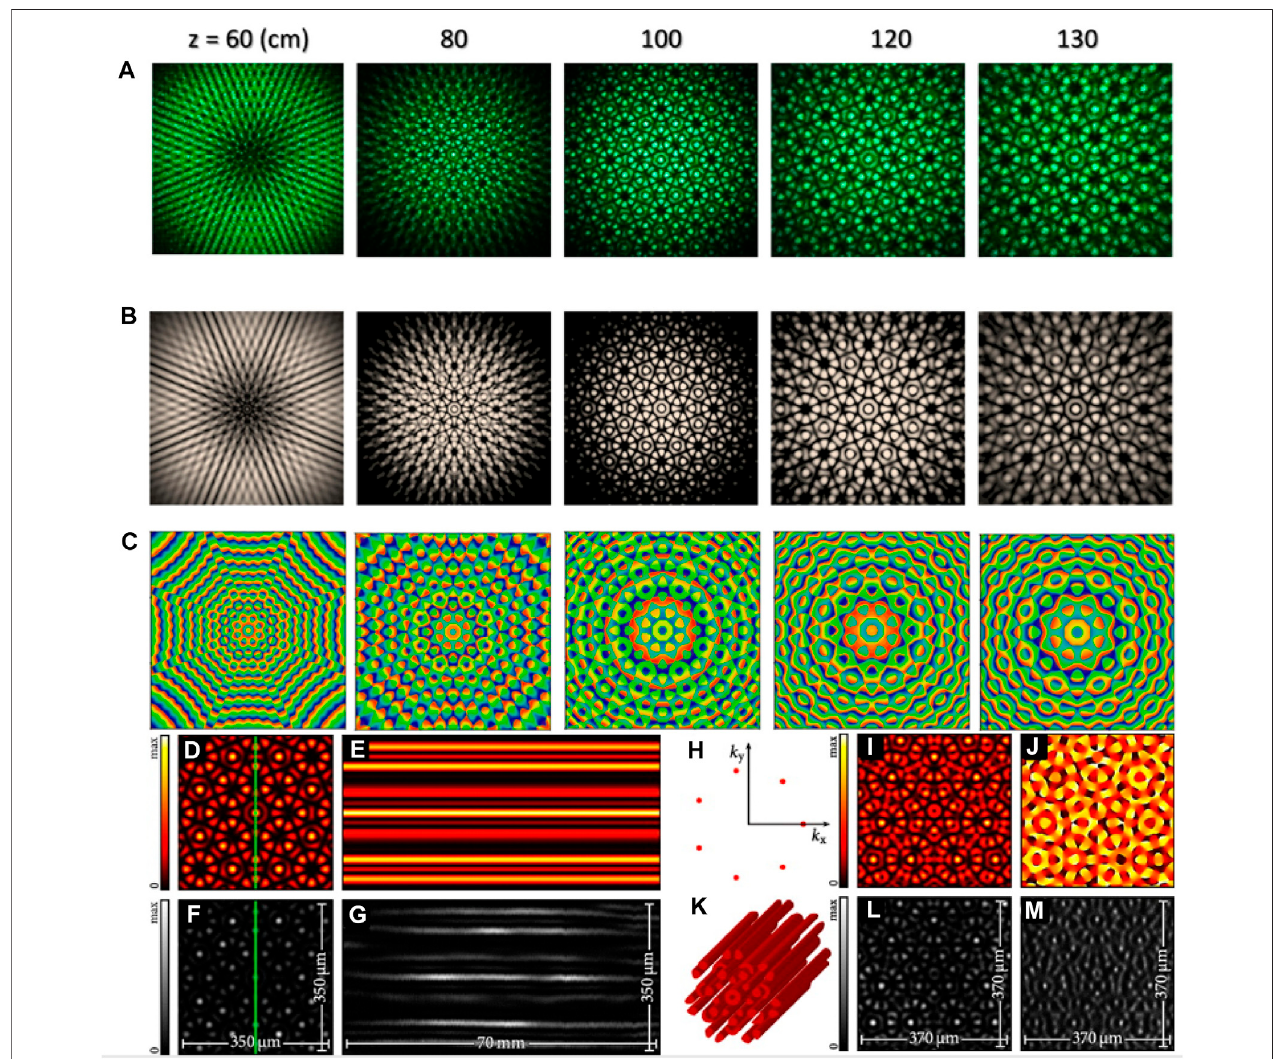
FIGURE 5 | (A) Experimental and (B) numerical pro fi les of the high-resolution kaleidoscopic lattices in the effective non-diffracting region when N (cid:2) 8. (C) Contour plots for the phase fi elds in (B) . Simulated (D) transverse spatial pattern and (E) longitudinal non-diffracting pro fi le of a prototypical discrete non-diffracting lattice beam. (F,G) The experiment corresponding to (D,E) . Transverse intensity pro fi le in (H) Fourier spaceand (I) real space, with (J) the corresponding phase in real space. (K) Iso- surface of the intensity for the non-diffracting light fi eld, (L) observed transverse beam pro fi le, and (M) guided beam in the discrete photonic lattice. Reproduced with permission from OSA [51]. Reproduced by permission of [55], @ IOP Publishing and Deutsche Physikalische